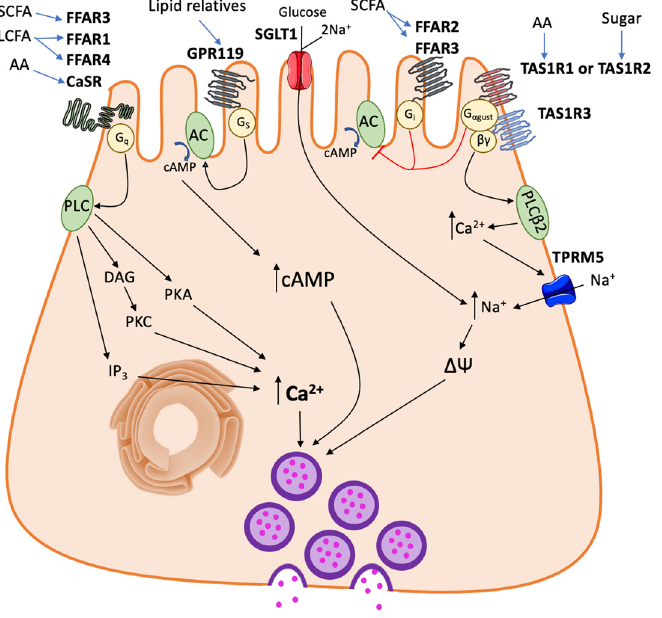
Figure 1. A schematic diagram of nutrient sensor signaling in an enteroendocrine cell. AA, amino acid; AC; adenylyl cyclase; cAMP, cyclic adenosine monophosphate; CaSR, calcium sensing receptor; DAG, diacylglycerol; FFAR, free fatty acid receptor; GPR119, G-protein receptor 119; IP3, inositol trisphosphate; LCFA, long chain fatty acid; PKA, protein kinase A; PKC protein kinase C; PLC, phospholipase C; PLC β 2, phospholipase C β 2; SCFA, short chain fatty acid; SGLT1, sodium/glucose cotransporter 1; TAS1R, taste 1 receptor; TPRM5, transient receptor potential cation channel subfamily M member 5.